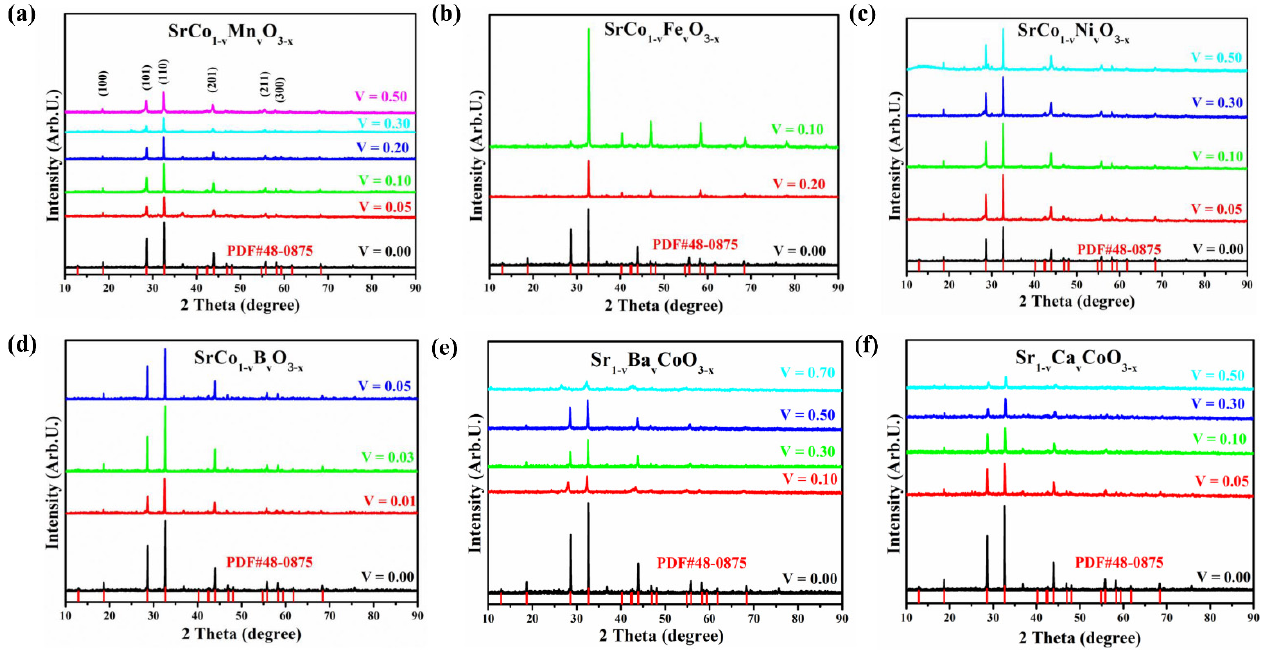
Figure 3. XRD patterns of Sr 1 − v A v CoO 3 − x and SrCo 1 − v R v O 3 − x [R = ( a ) Mn; ( b ) Fe; ( c ) Ni; ( d ) B; A = ( e ) Ba; ( f ) Ca].